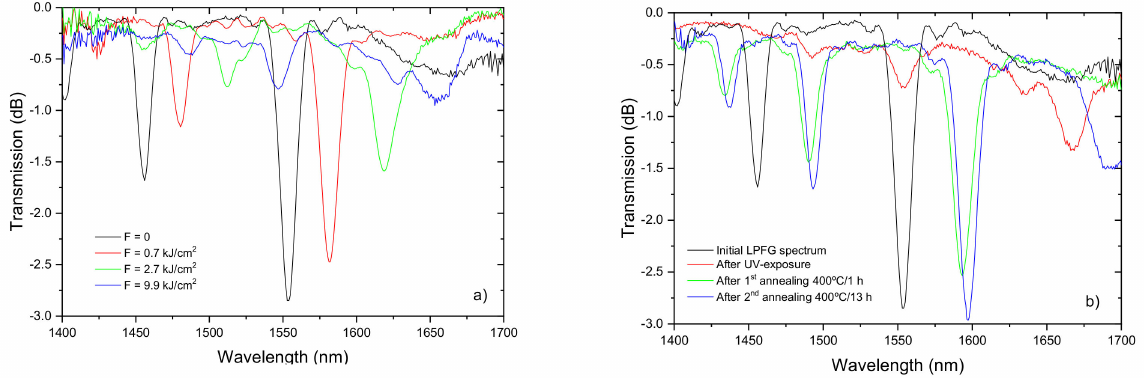
Figure 17. ( a ) Erasure of a LPFG arc-induced in a B/Ge co-doped fiber through uniform uv-radiation and ( b ) recover through thermal annealing. Reprinted with permission from ref. [96]. © 2021 Wiley Periodicals, Inc.